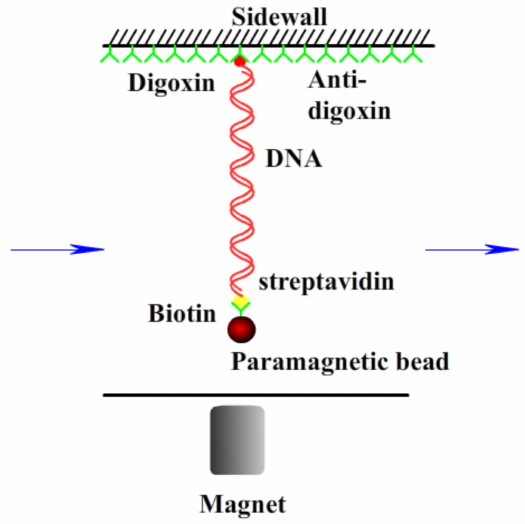
Figure 1. A schematic diagram of magnetic